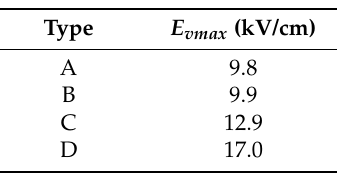
Table 3. Calculated maximum electric field component vertical to the dielectric surface of all four bushing samples.